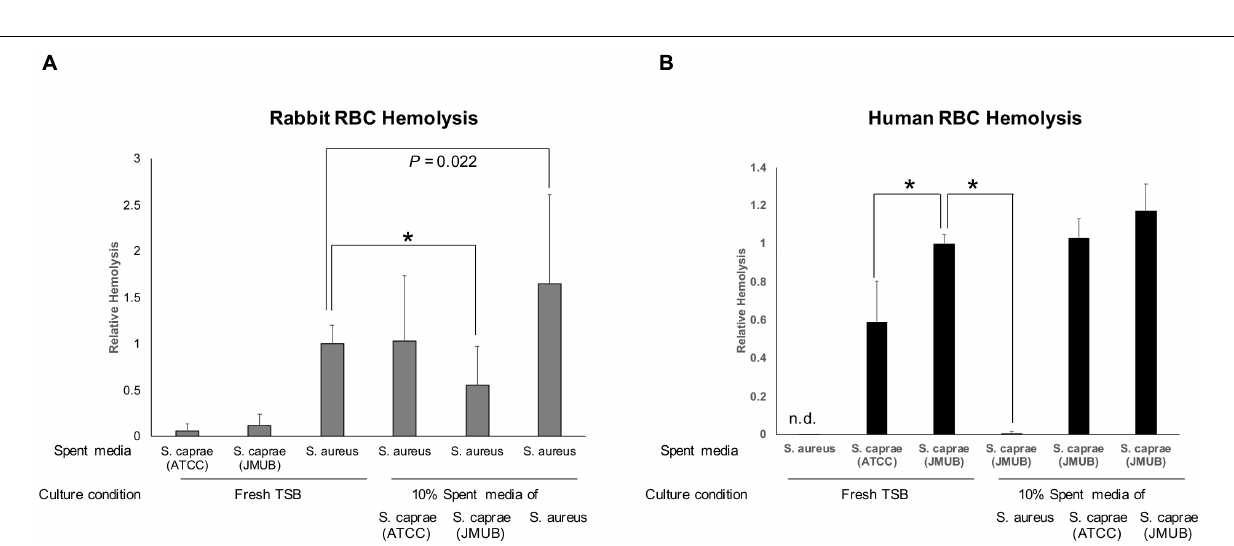
Frontiers in Microbiology |